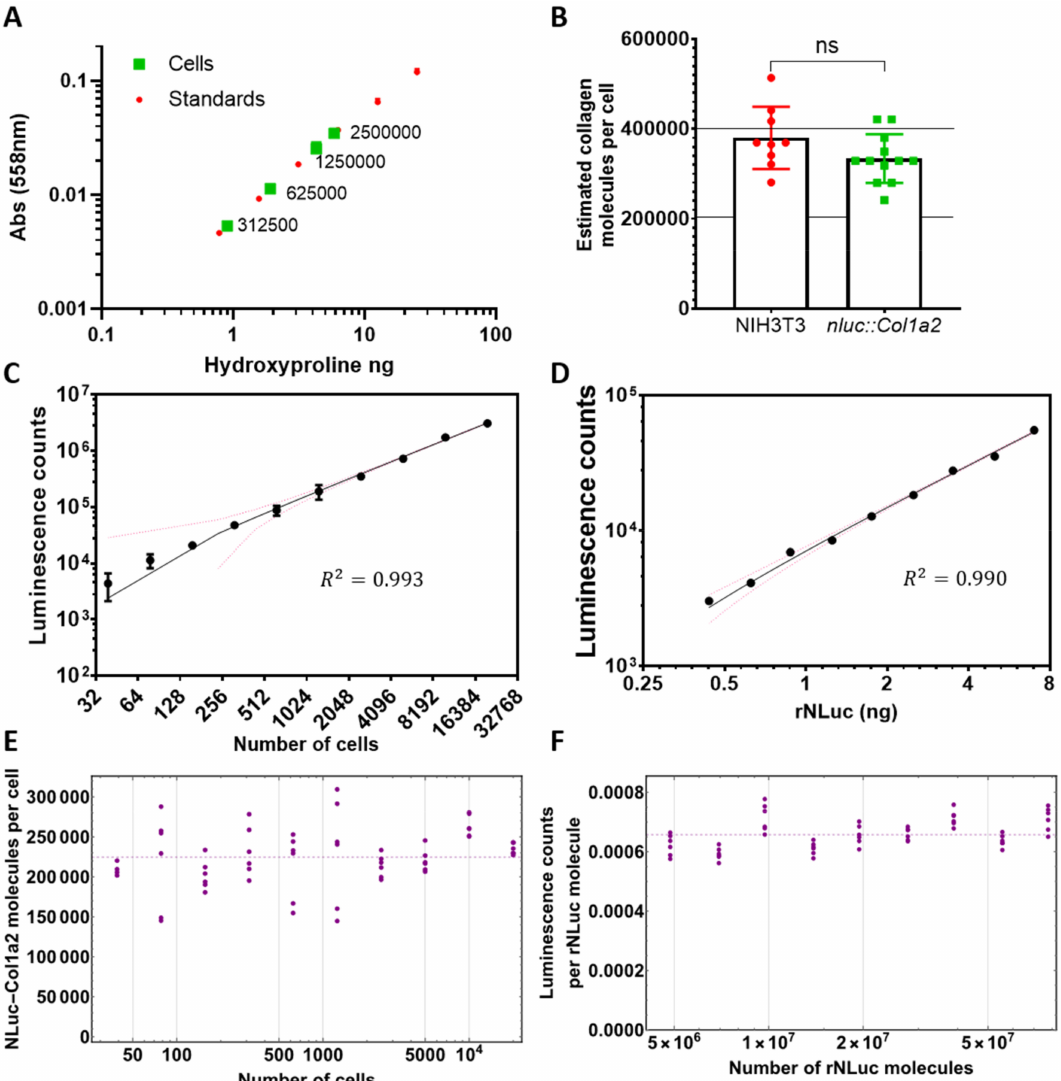
Figure 2. Quantitation of intracellular collagen molecules. ( A ) The quantity of hydroxyproline in known numbers of cells was calculated using known concentrations of hydroxyproline. Greater than 300,000 cells were required to ensure accurate comparison to hydroxyproline standards. ( B ) Estimated numbers of collagen molecules per cell based on hydroxyproline. n = 3 independent experiments each conducted in triplicate, NIH3T3 and n = 4 independent experiments each conducted in triplicate. Bars show mean ± SD. ( C ) Bioluminescence counts per second of nluc::Col1a2 cells scales with cell number. n = 3 independent assays, each recorded n = 4 times ( D ) Correlation of known quantities of recombinant NLuc (rNLuc) with luminescence counts. n = 3 independent assays, each recorded n = 4 times. ( E ) Across the range of rNLuc concentrations tested, reaction conditions allowed consistent counts per rNLuc molecule to be measured. ( F ) By comparing the bioluminescence from C and D, the number of NLuc-PC-I molecules per cell could be